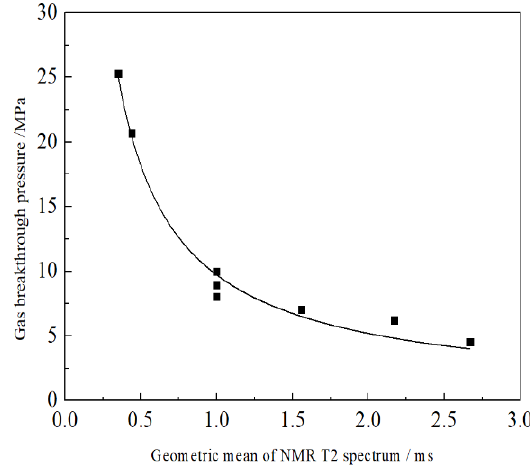
Figure 11. Gas breakthrough pressure vs. geometric mean of NMR T 2 spectrum.